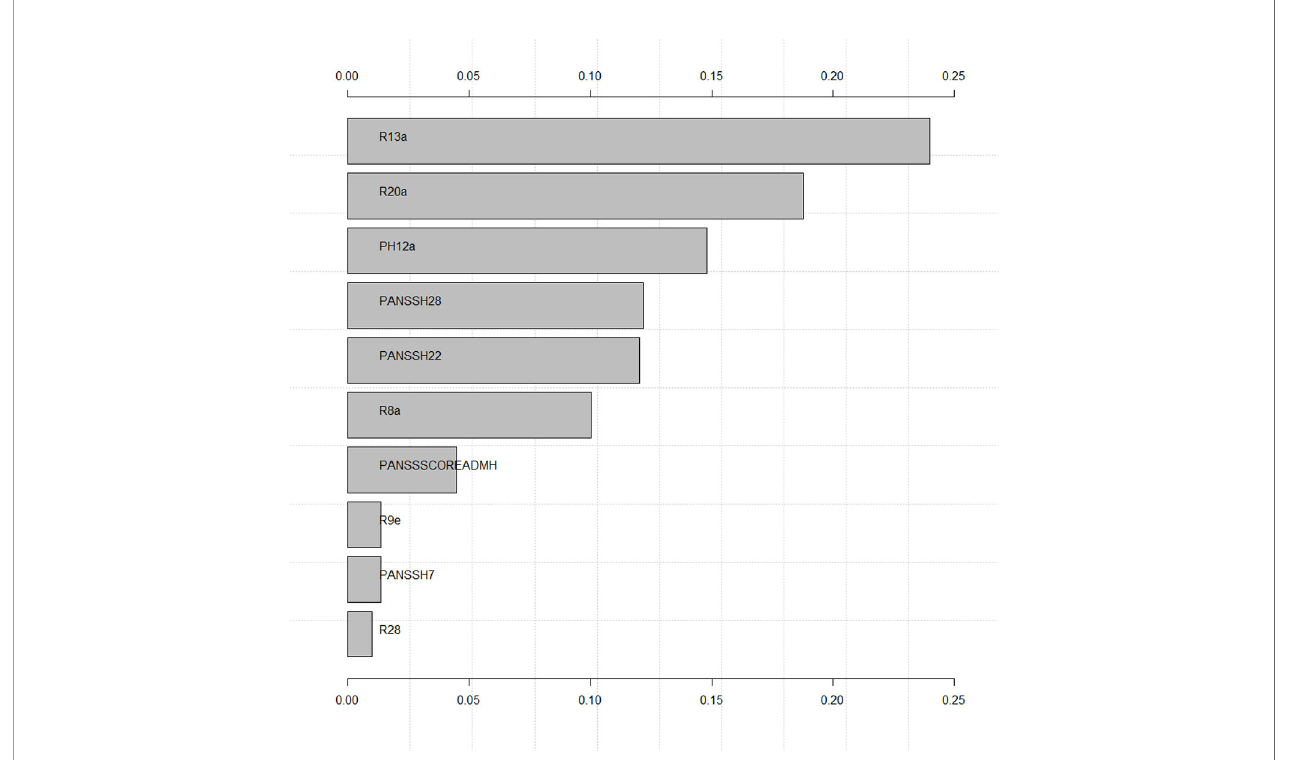
FIGURE 2 | Variable importance of fi nal model. Variable descriptions are presented in Table 3